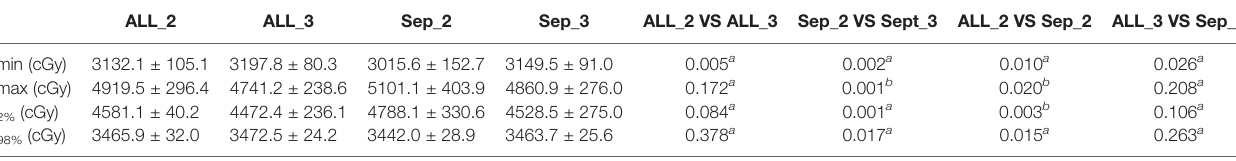
TABLE 3 | DVH parameters for PTV among the four